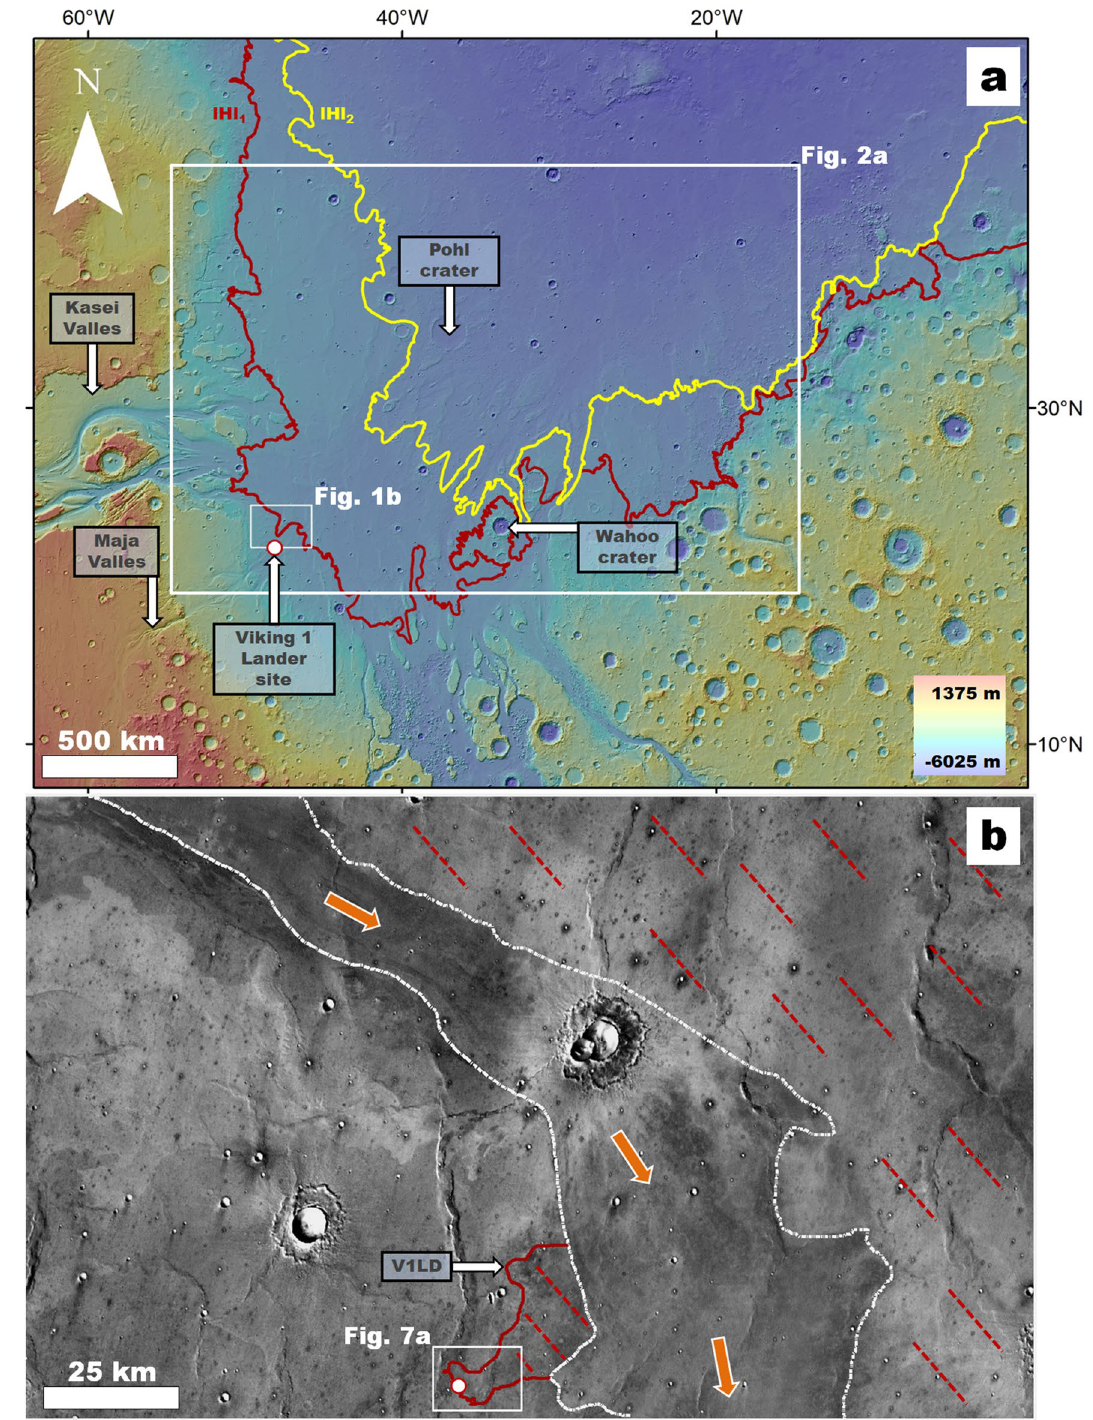
Figure 1. (a) View of the Chryse Planitia region showing the margins of older and younger megatsunamis (i.e., unit members lHl 1 [solid red line] and lHl 2 [solid yellow line] as mapped by Rodriguez, et al. 6 ) and the location of Pohl crater, Wahoo crater, Maja Valles, and Kasei Valles. The red-circled white dot indicates the location of the Viking 1 Lander (V1L). The map base is a MOLA DEM overlying a shaded relief (460 m per pixel, credit: MOLA Science Team, MSS, JPL, NASA). (b) Close-up view on panel ( a ) showing the revised extent of the older megatsunami (frontal margins [solid red line], covered areas [dashed red lines]). The white dotted lines indicate the margins of a Kasei Valles channel dissecting the deposit. The red-circled white dot marks the location of the V1L. The orange arrows reconstruct the overall flow direction from Kasei Valles (Figs. S4 and S5). The base image is part of a THEMIS Day IR (infrared) Global Mosaic (http:// www. mars. asu. edu/ data/, 100 m per pixel, credit: Christensen, et al. 7 ). We produced this figure using Esri’s ArcGIS 10.3 (http:// www. esri. com/ softw are/